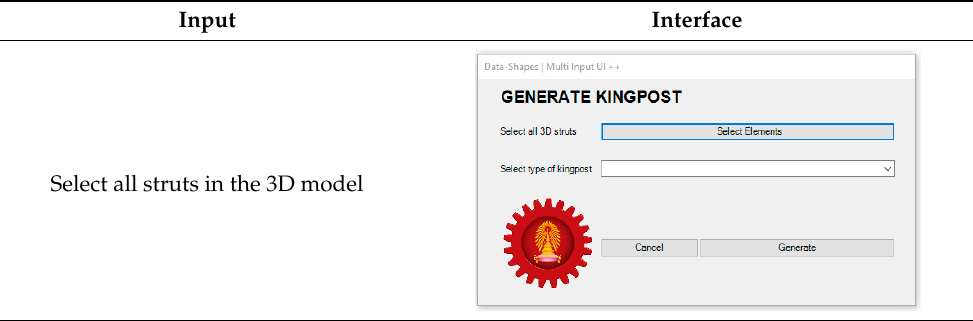
Table 7. The result of structural kingpost generation.